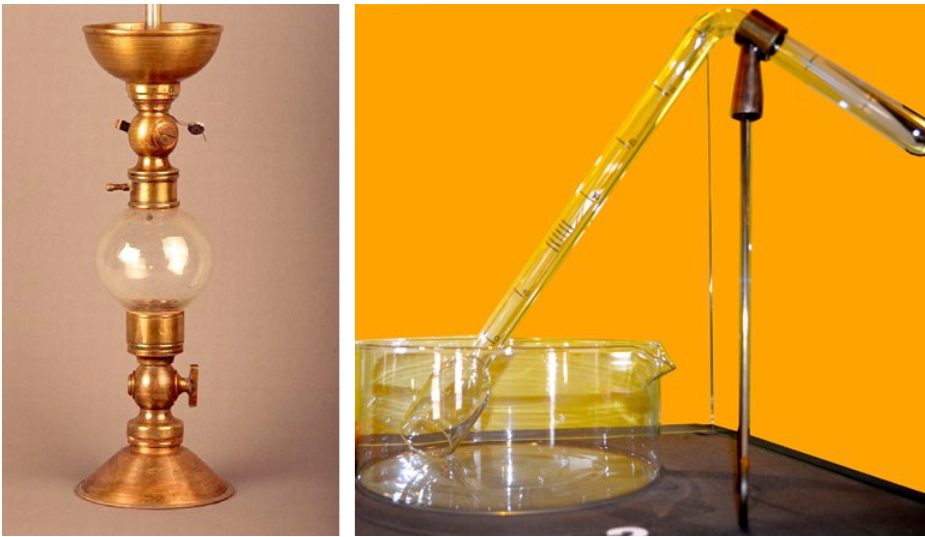
Figure 3. (Left) A view of the lower part of a copy of the Volta-type eudiometer. (Right) Modern replica of Spallanzani’s phosphorus eu- diometer exhibited at the Centro Studi Lazzaro Spallanzani. Courtesy of Tempio Voltiano, Musei Civici di Como, Comune di Como and of Centro Studi Lazzaro Spallanzani, Scandiano, photography by the